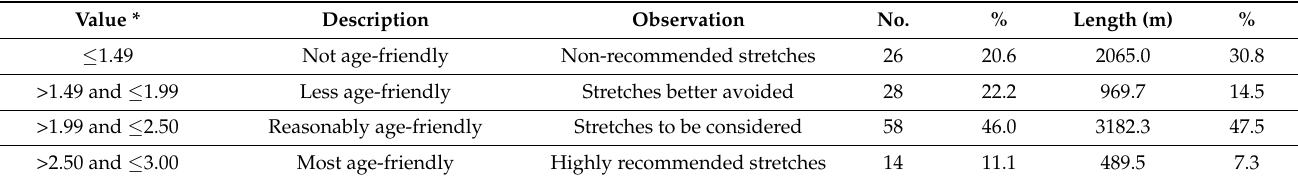
Table 17. Review of the Walkability Index for Elderly Health (WIEH) values and outcome in the study area.